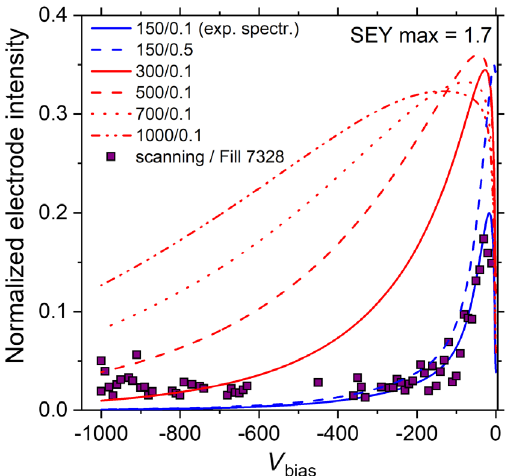
FIG. 15. Variation of the normalized electrode intensity vs V . Experimental data (blue circles and purple squares) were bias recorded during fills 6640 and 7328, and values were calculated using the experimental electron energy spectrum and several SEY (color